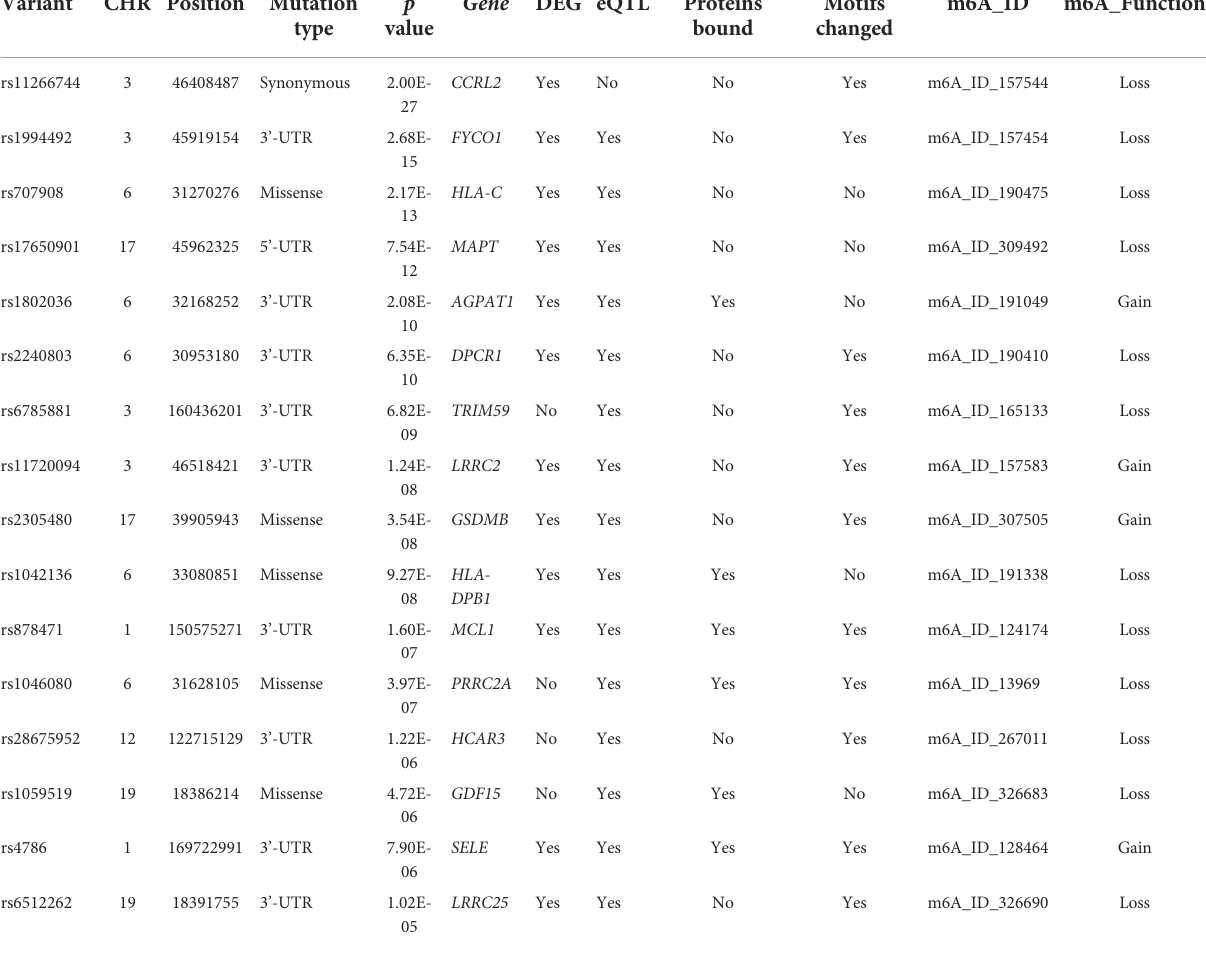
TABLE 1 Top 20 most signi fi cant m6A single nucleotide polymorphisms associated with oral ulcers.